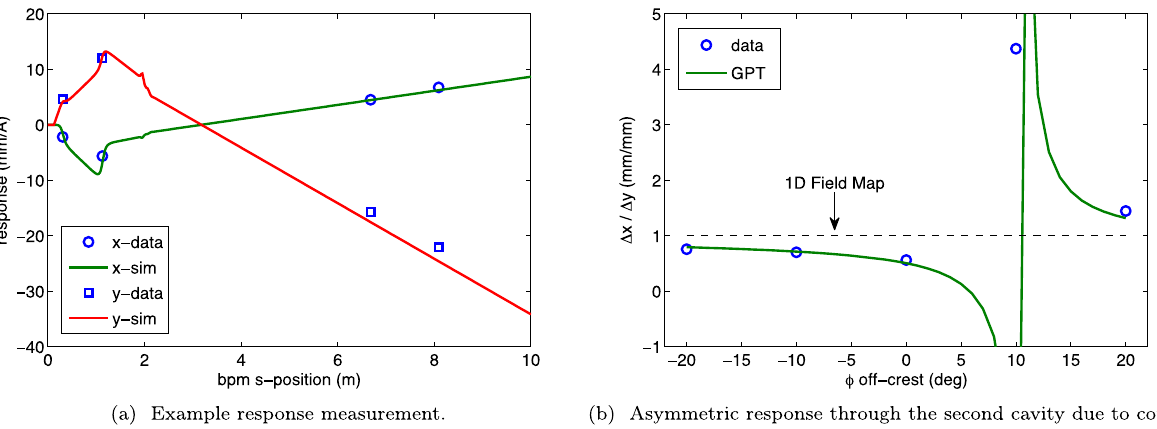
FIG. 7. Response measurements: (a) the response from the first set of correctors through the first SRF cavity. The cavity was set to 1 MV on-crest. (b) The response asymmetry due to the coupler fields in the second cavity as a function of cavity phase. The cavity voltage was 1.5 MV. The dashed line shows the expected response from a cylindrically symmetric, or 1D field map model of the